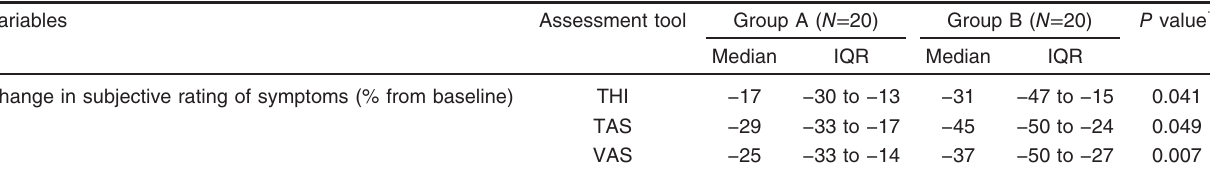
Table 6 Percentage of change in subjective rating of symptoms in either study group